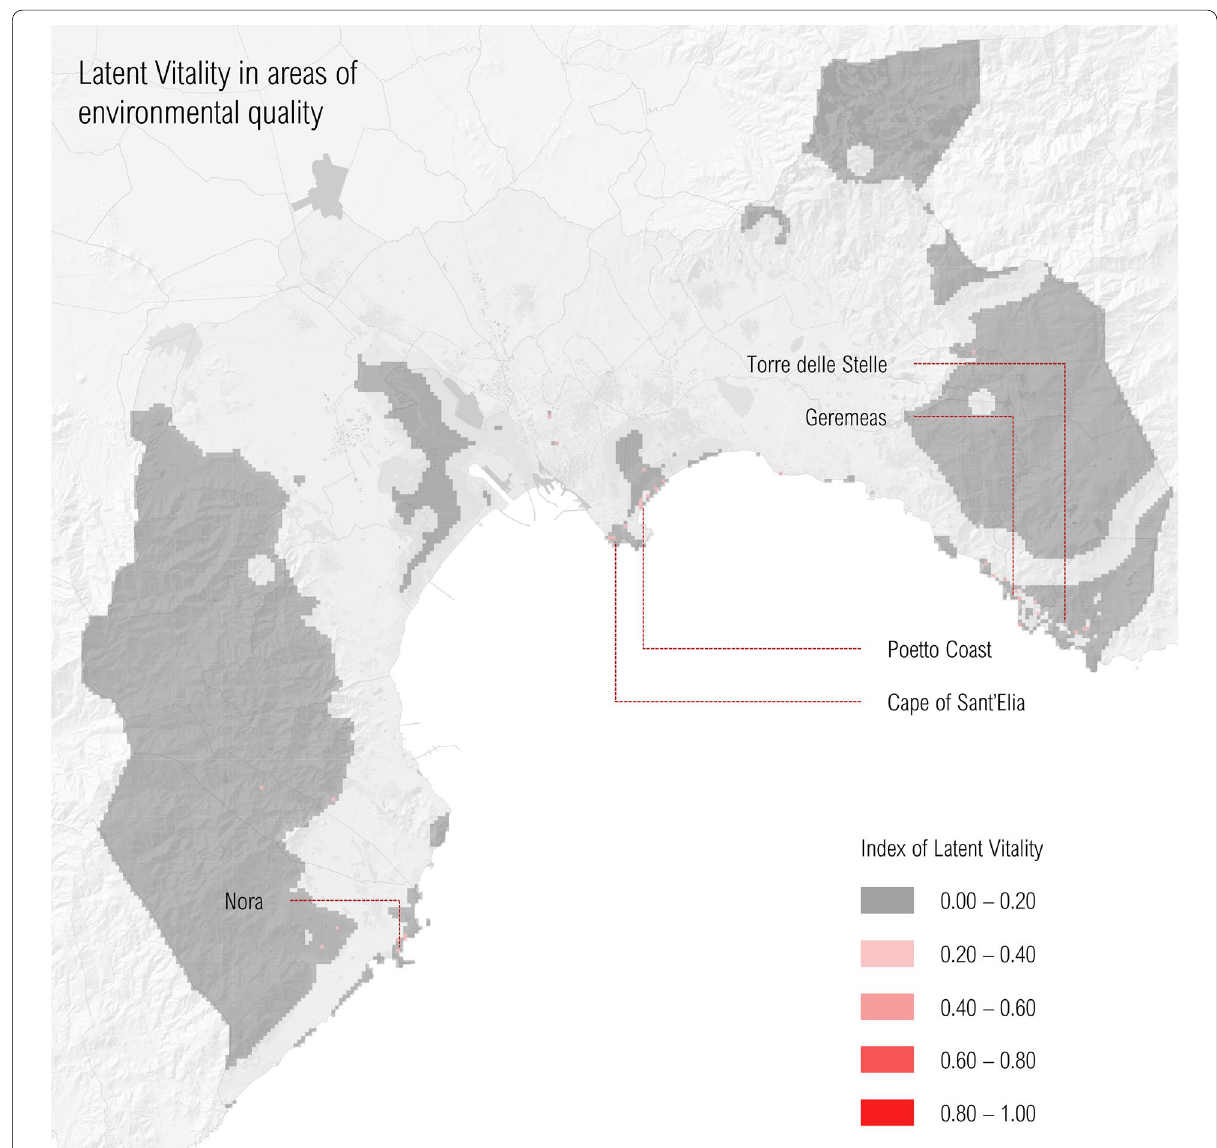
Fig. 8 Distribution of the values of the Synthetic Index of Latent Vitality (I_VIBE) across the areas of pre-eminent environmental quality in the Metropolitan City of